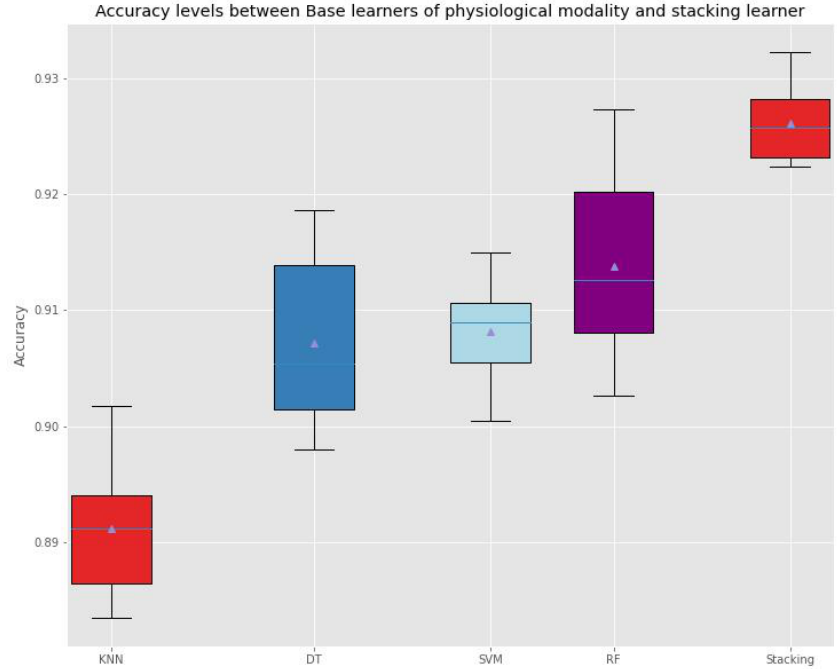
Figure 17. Accuracy Levels Comparison between Base classifiers of Physiological modality and the Stacking Learner.